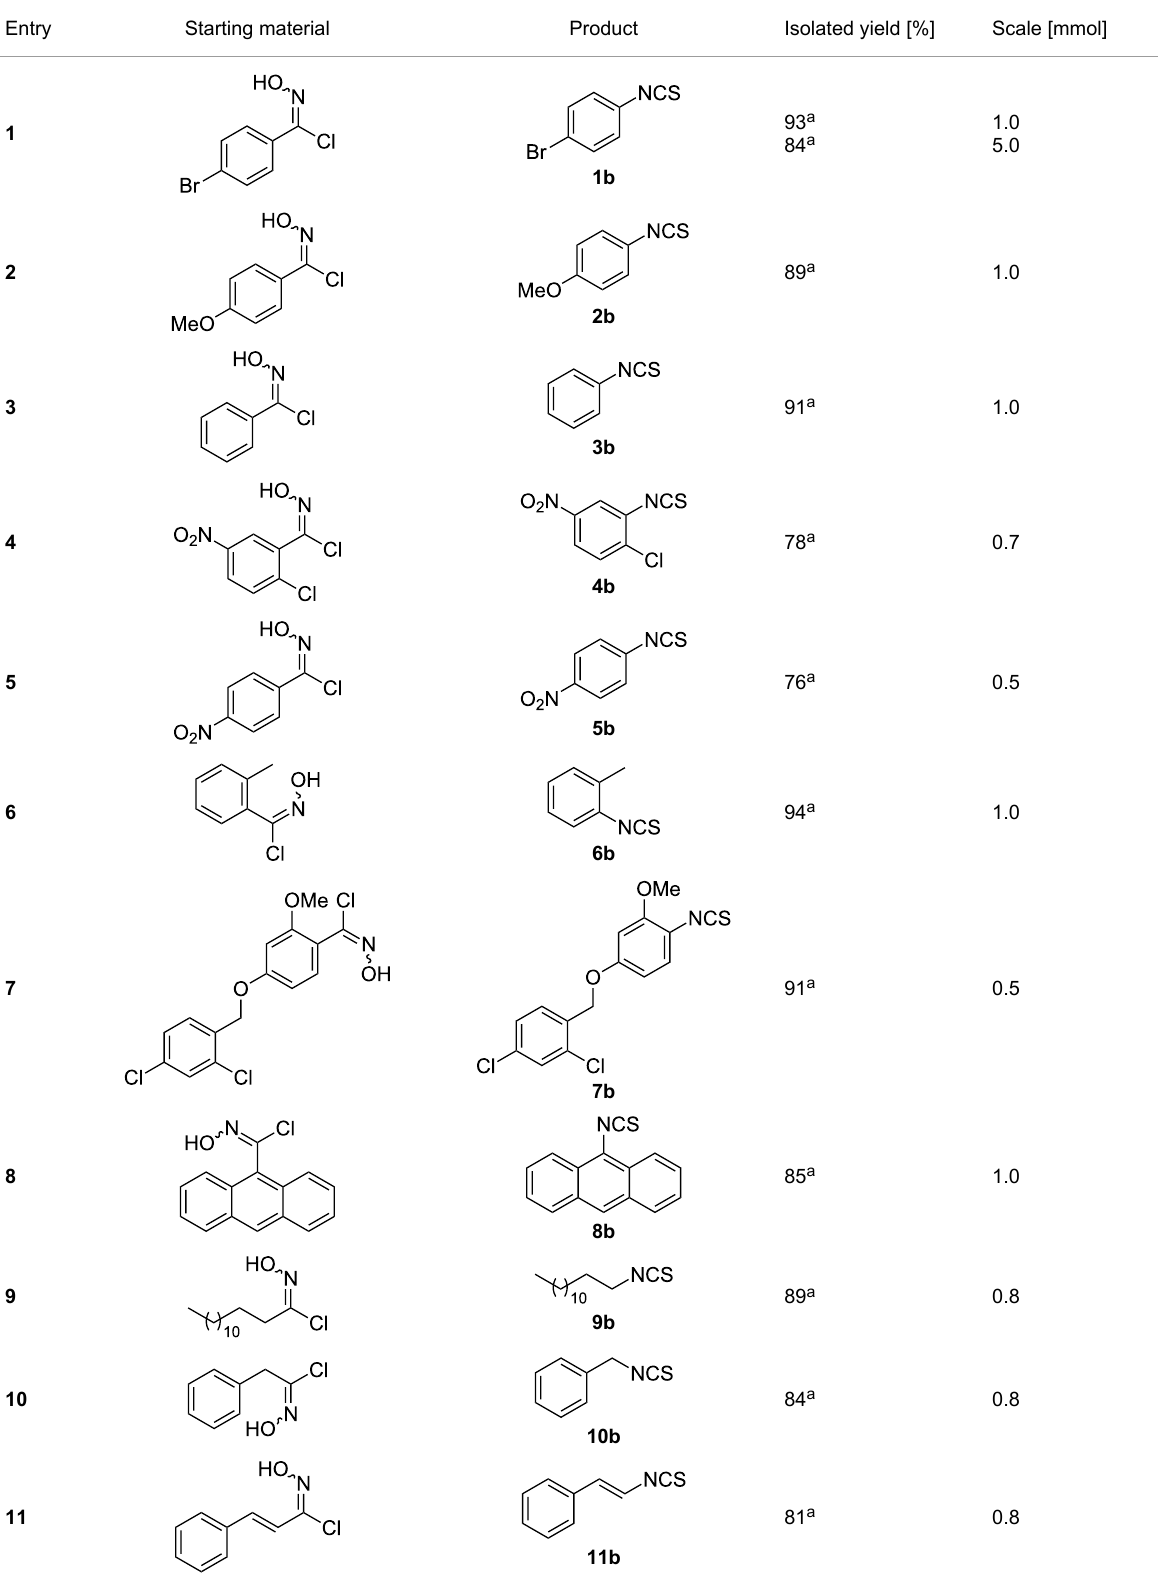
Table 2: Isothiocyanates prepared in flow.